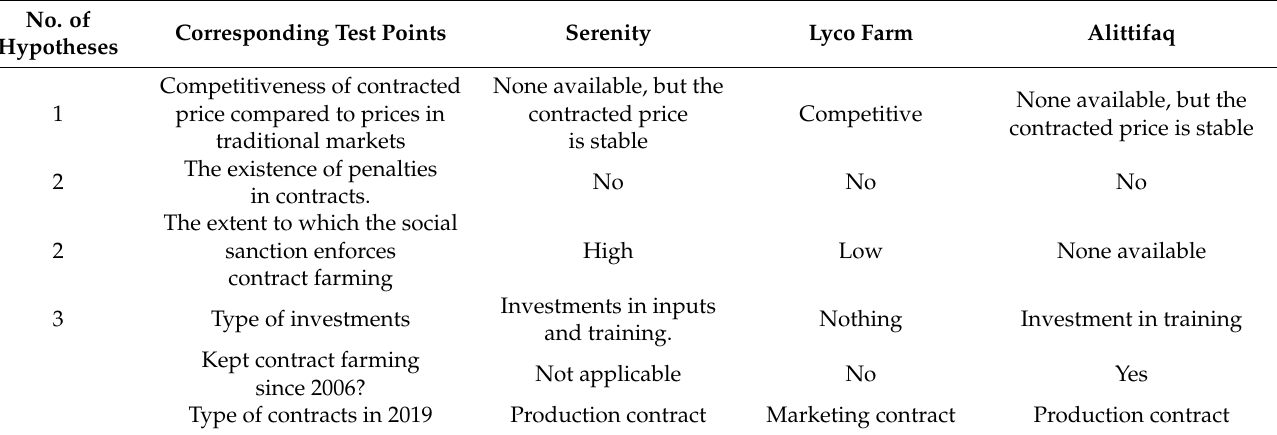
Table 1. Summary of data for testing